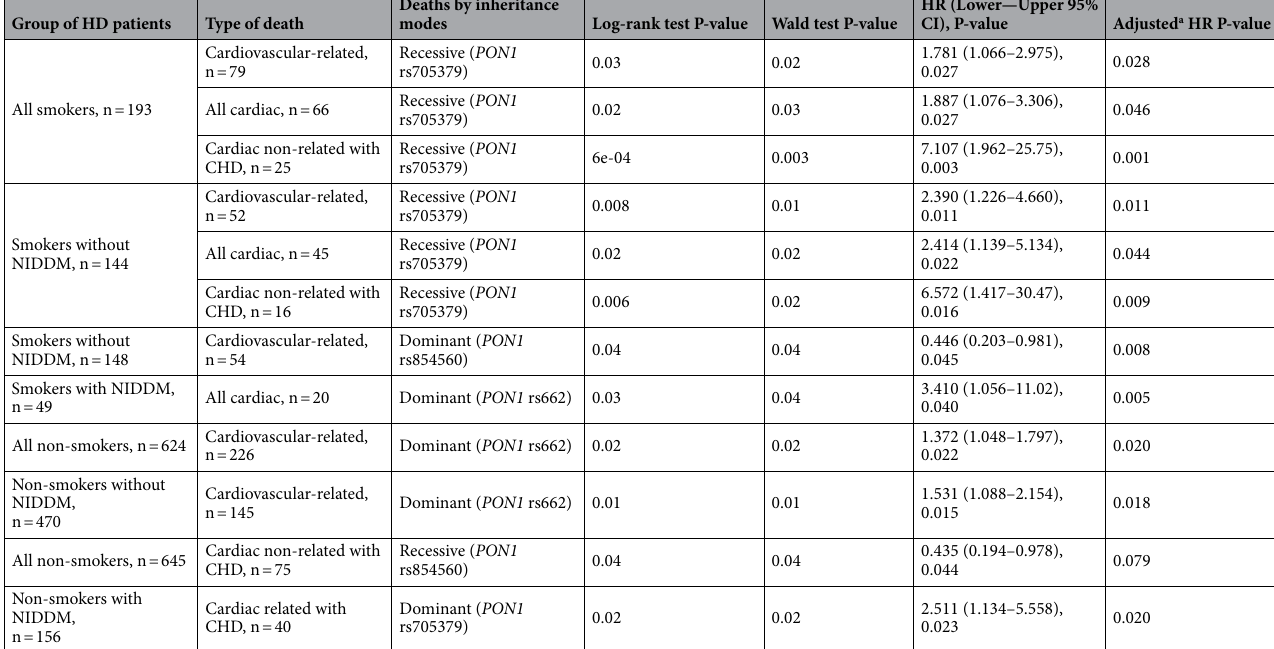
Table 3. Analysis of mortality concerning PON1 polymorphisms in HD patients showing significant P-values by the log-rank test and Wald test. CI coincidence interval, HD hemodialysis, HR hazard ratio, NIDDM non- insulin-dependent diabetes mellitus, PON1 paraoxonase 1 gene. a Adjusted for the male sex, age, and HDL-